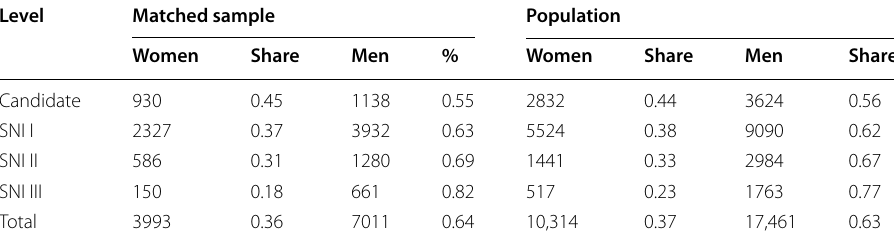
Table 9 Number of women and men in each SNI level: matched sample and population Level